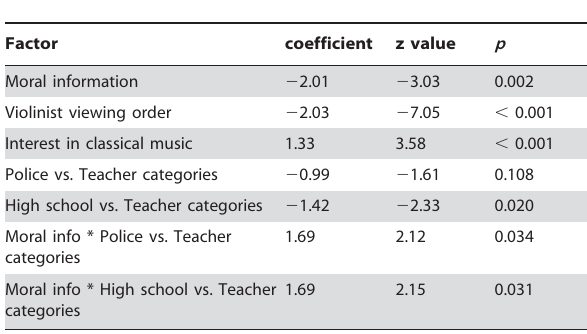
The two last lines in the table report significant interactions between how participants responded to moral information (voted for or against the immoral versus socially integrated violinist) and which socio-professional category they belonged to (comparing either police or high school to teacher). This indicates that both police and high school categories differed from the teacher category with respect to their propensity to punish. Moreover, the order in which participants viewed the violinists, as well as participants’ stated interest in classical music, were